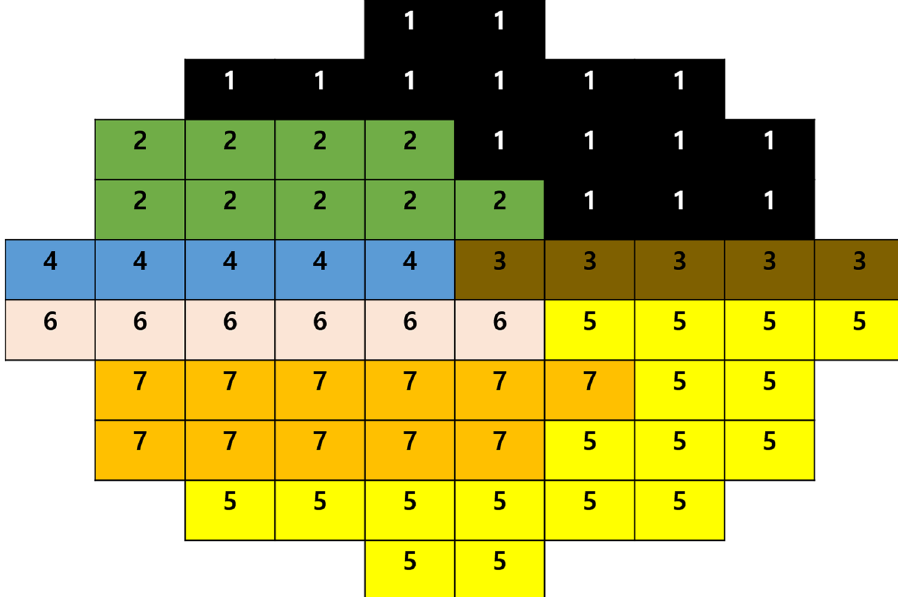
Figure 3. Cluster map of 10-2 visual field for sectoral analysis.